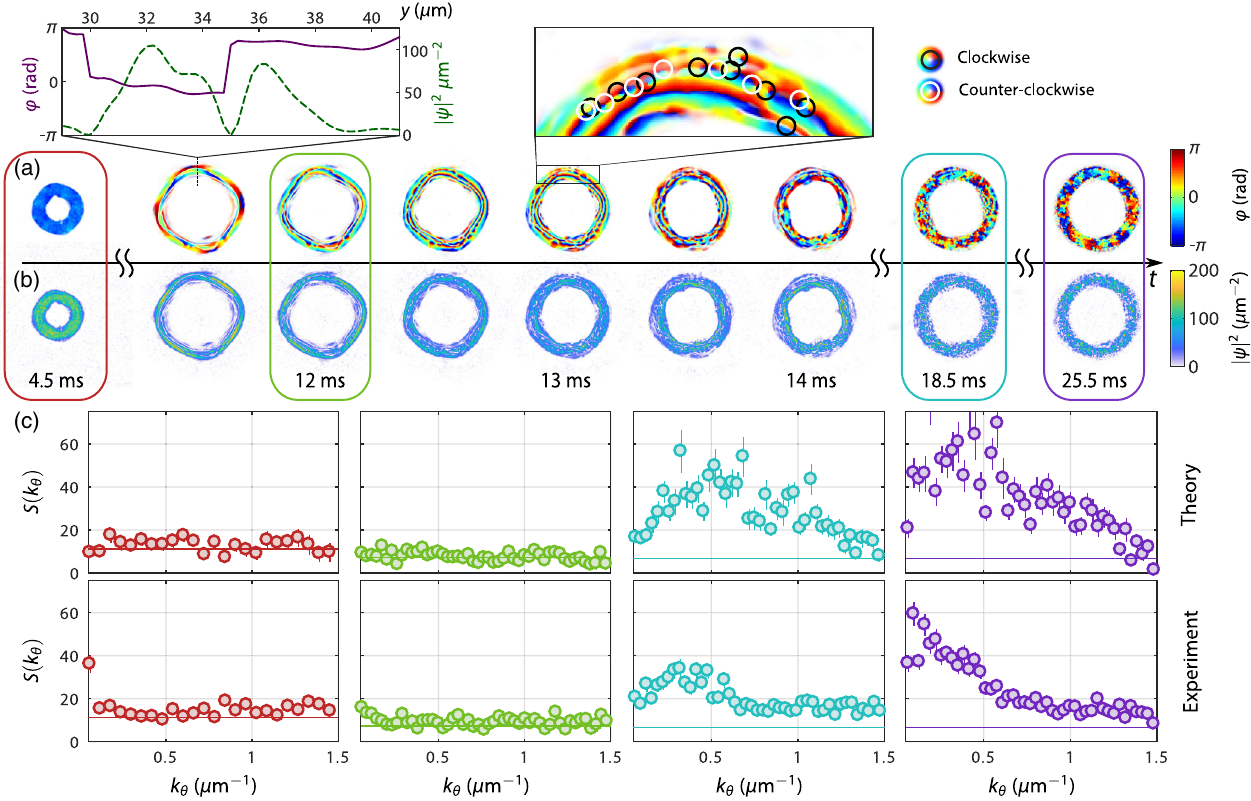
FIG. 4. Dynamics in the radial direction and generation of azimuthal excitations for a scale factor of a ¼ 1 . 9 ð 1 Þ . (a,b) A single realization of the simulated BEC wave function ’ s phase (a) and magnitude j ψ j 2 (b) vs time. (Left inset) Cross section along ˆ y of the phase and density at t ¼ 11 . 5 ms. (Right inset) Zoomed section of the phase profile at t ¼ 13 ms, with the location of vortices highlighted. (c) Azimuthal static structure factor. The color indicates the time and matches the vertical lines in Fig. 3 and the rectangles in (a) and (b). The horizontal lines indicate the imaging detection threshold (see